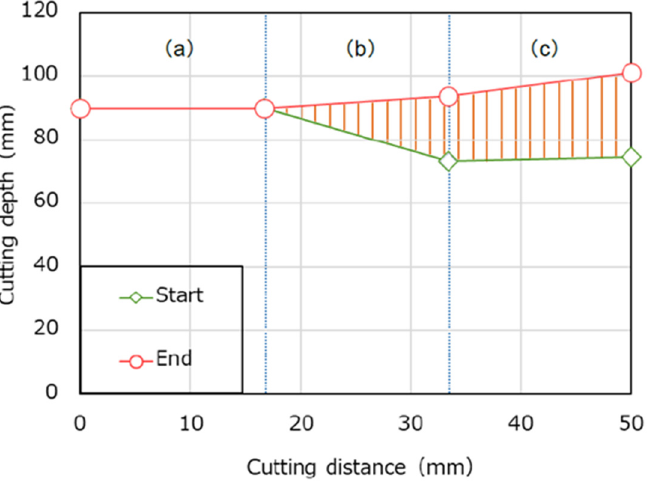
Figure 8. Result in the cutting difference due to difference in the cutting distance (laser: 9 kW; speed: 60 mm/min; strength: 20 N/mm 2 ).